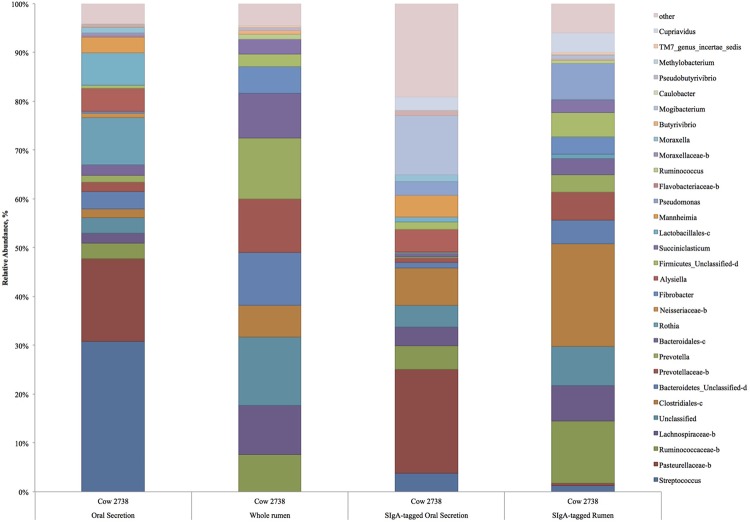
Relative abundance of predominant taxa in whole and IgA-tagged oral secretions and rumen samples of individual Cow 2738. Letter behind taxonomy indicates unclassified: b – genus, c – family and genus, d – order, family and genus.